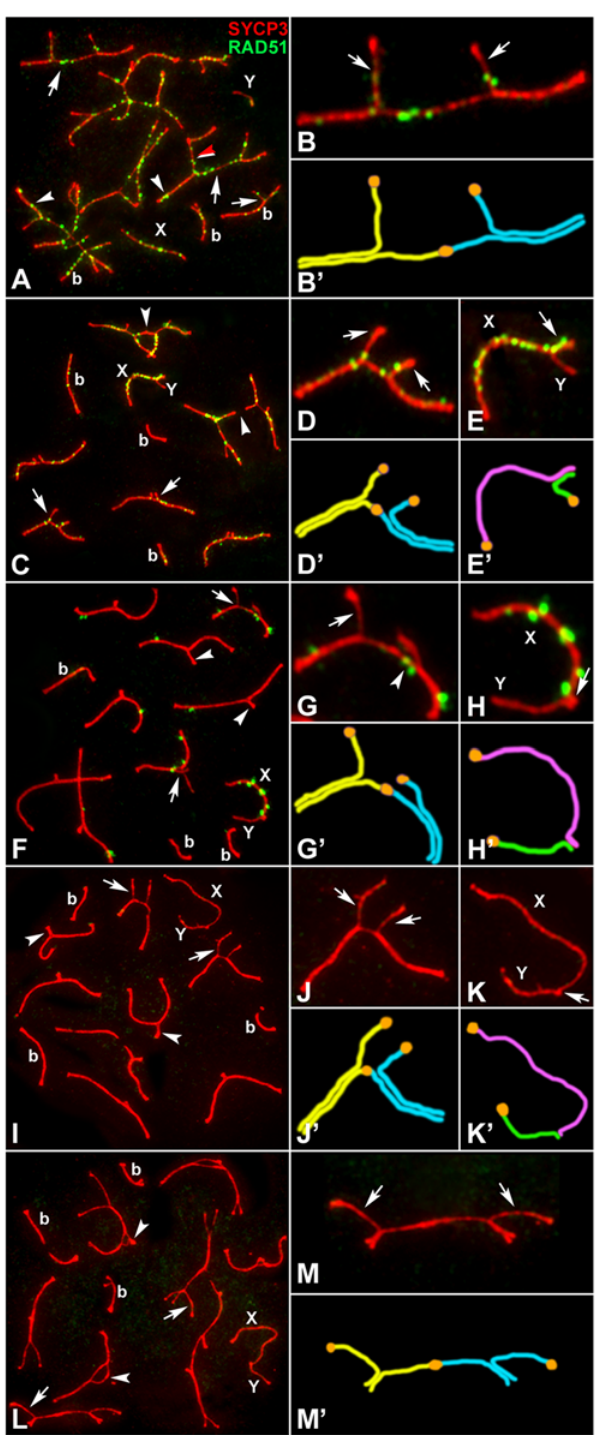
Figure 1. Localization of RAD51 (green) and SYCP3 (red) during prophase-I in 2n=32 spermatocytes. (A) Zygotene. RAD51 is distributed in both synapsed LEs (arrowheads) and unsynapsed AEs (arrows) in bivalents (b) and trivalents. A distal heterologous association is observed between two trivalents (red arrowhead). Sex chromosomes (X, Y) appear separated. (B) Magnification of a trivalent shown in (A) with RAD51 foci on unsynapsed acrocentric (arrows) and metacentric chromosomes. Note that the synapsis starts only from one chromo- somal end. (B’) Schematic representation of the trivalent shown in (B). Homology between the metacentric and the acrocentrics is